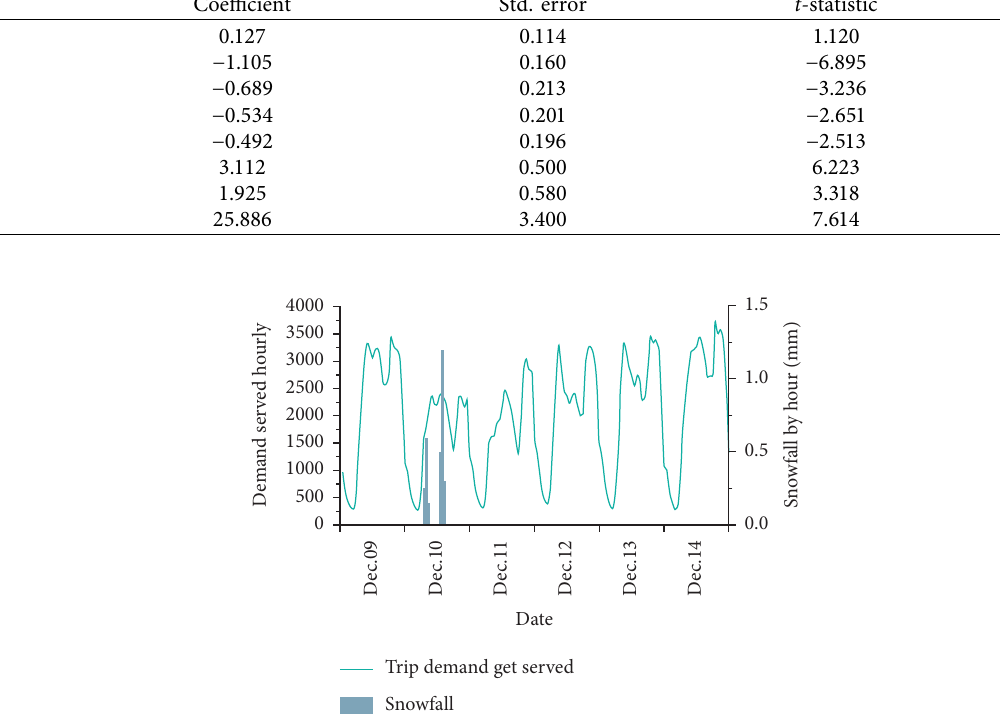
Figure 5: Trip demand getting served in each hour during the 6 days.